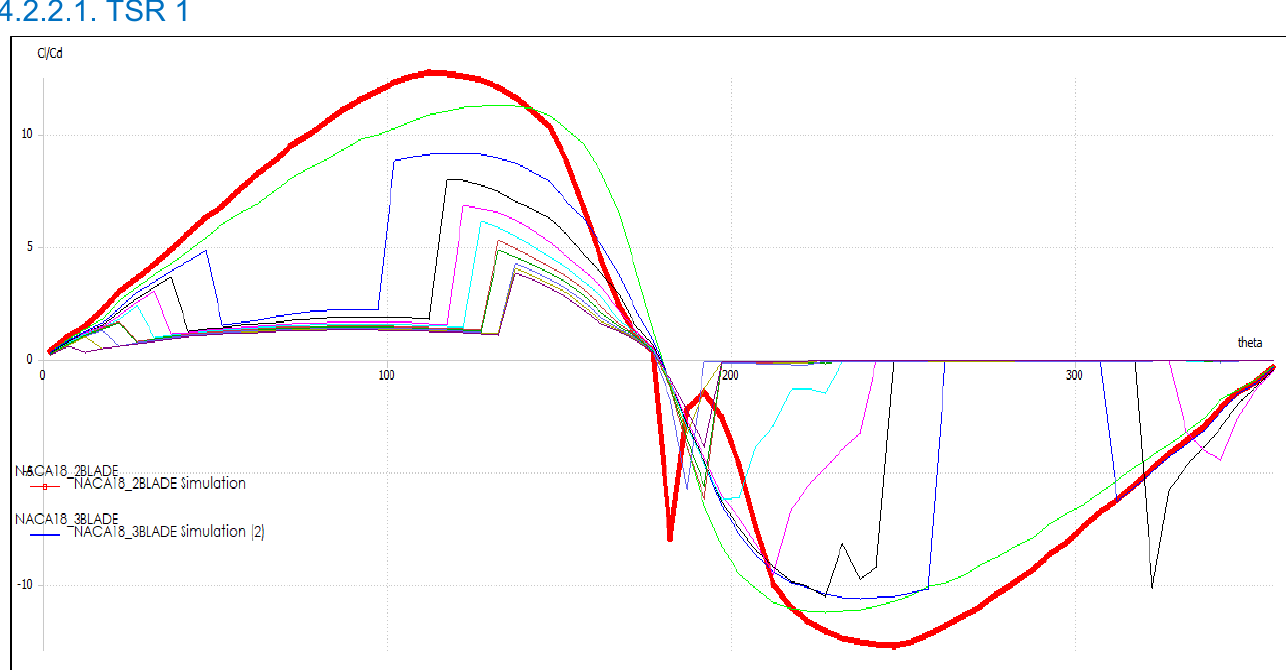
Figure 23. Cl/Cd vs theta plot of top-section for TSR 1